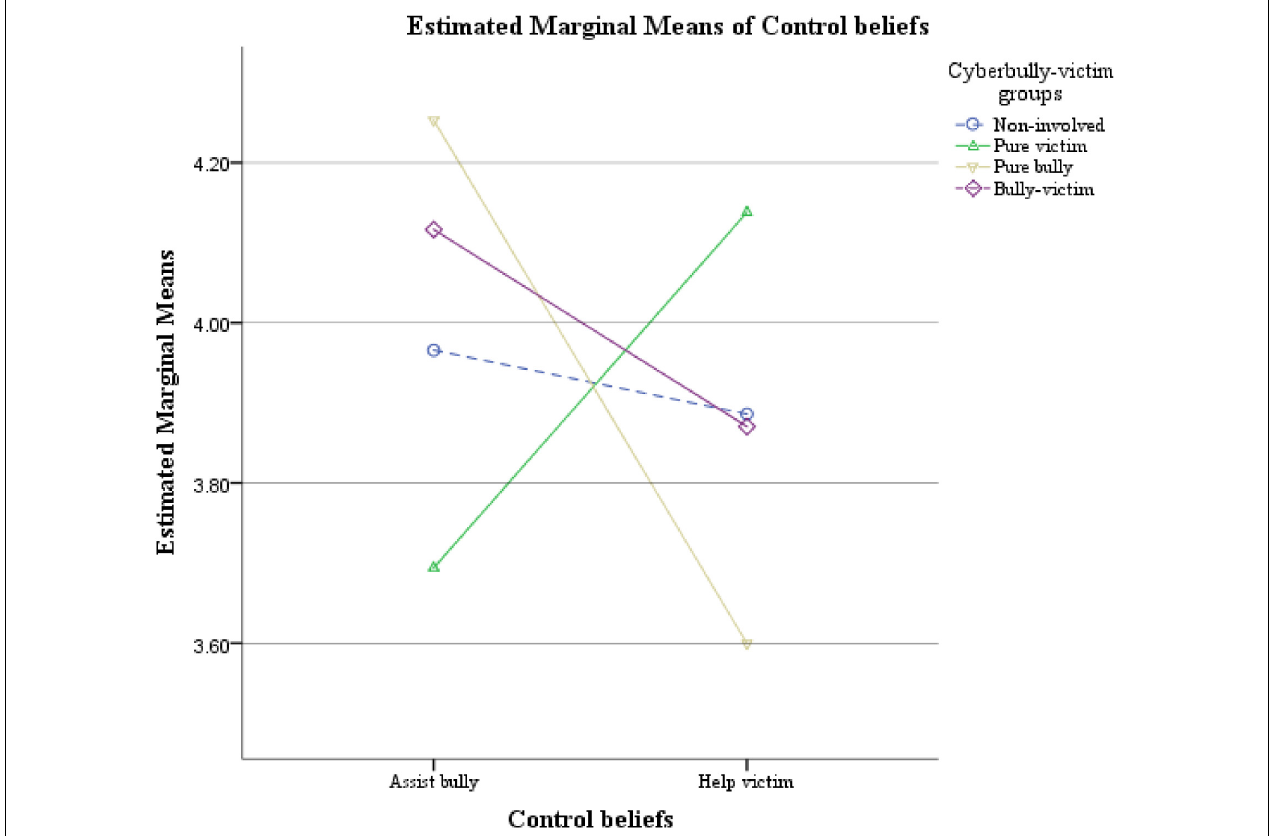
FIGURE 4 | Estimated marginal means of the 2-way interaction between cyberbully-victim group and type of control beliefs about bystander behaviors.